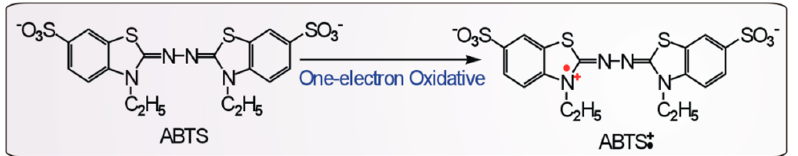
Figure 4. The dose response curves of dihydromyricetin (DHM) and positive control Trolox in the ABTS• + radical-scavenging assay ( A ) and Cu 2+ -reducing power assay ( B ). Each value is expressed as the mean ± SD ( n = 3). Trolox, [(±)-6-hydroxyl-2,5,7,8-tetramethlychroman-2-carboxylic acid].